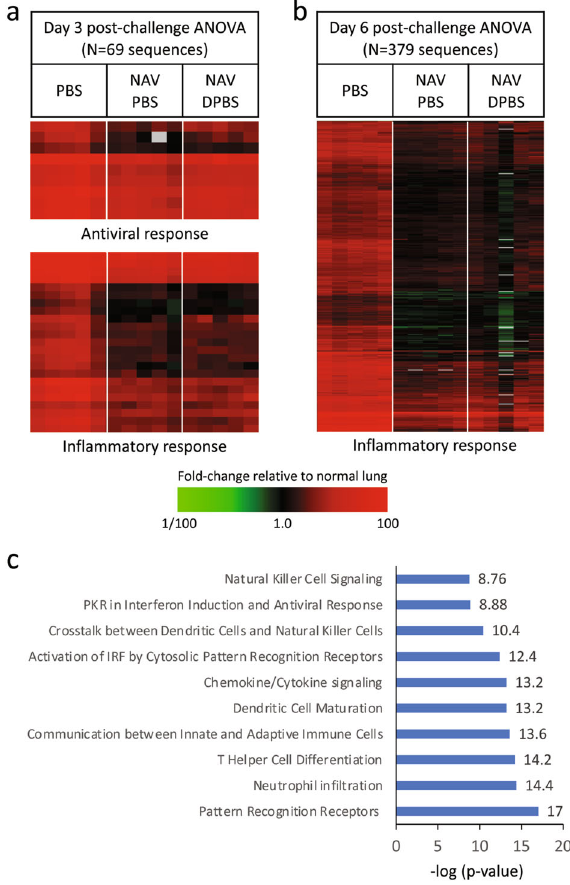
Fig. 8 NAV PBS and NAV DPBS vaccination reduced antiviral and in fl ammatory response gene expression following viral challenge. Expression microarray analysis was performed on total RNA isolated from lungs on days 3 and 6 post-challenge ( n = 5 mice per condition per time point). a Heatmaps showing expression of antiviral and in fl ammatory response genes identi fi ed by ANOVA ( p < 0.001) that showed >2-fold change in expression between PBS, NAV PBS, and NAV DPBS vaccinated groups on day 3 post-viral challenge. Due to the small number of sequences ( n = 69) identi fi ed at this timepoint, pathway classi fi cation analysis was not performed (gene IDs are shown in Supplemental Figs. 1 and 2). b Heatmap showing expression of antiviral/immune response genes identi fi ed by ANOVA ( p < 0.001 with >2-fold change in expression) on day 6 post-viral challenge. Red indicates higher expression of sequences in infected mouse lung compared to normal unvaccinated, uninfected, age- matched mouse lung, while green indicates lower expression, and black indicates no change. c Pathway classi fi cation of genes identi fi ed by ANOVA on day 6 post-viral